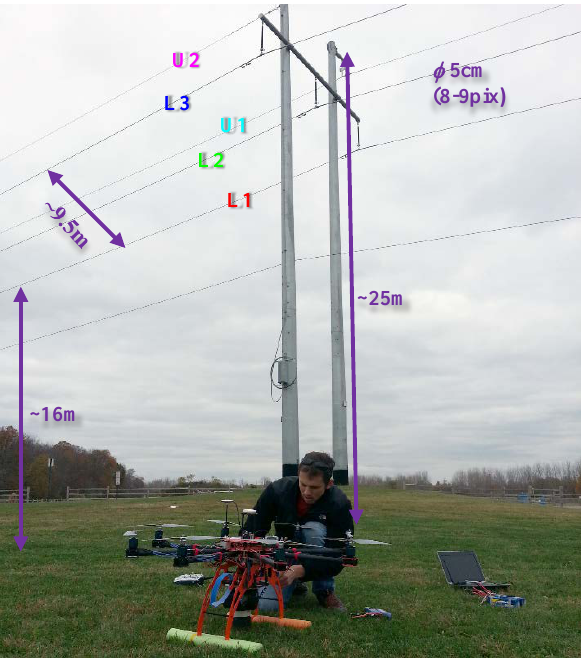
Figure 4. Part of the mapped transmission line section and used